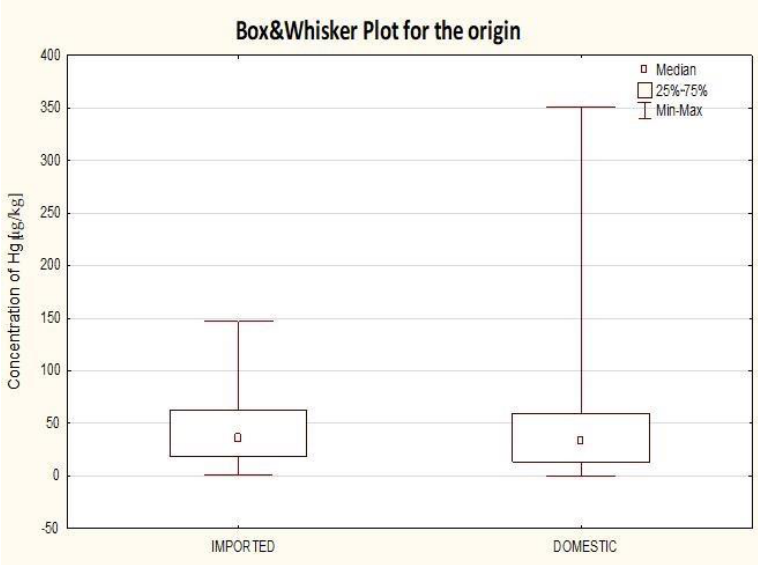
Figure 3. Box and whisker plot for content of Hg for canned fish produced in Poland (domestic, n = 192, median = 36.6) and outside Poland (imported, n = 60, median = 33.4; total n = 252) (µg/kg).